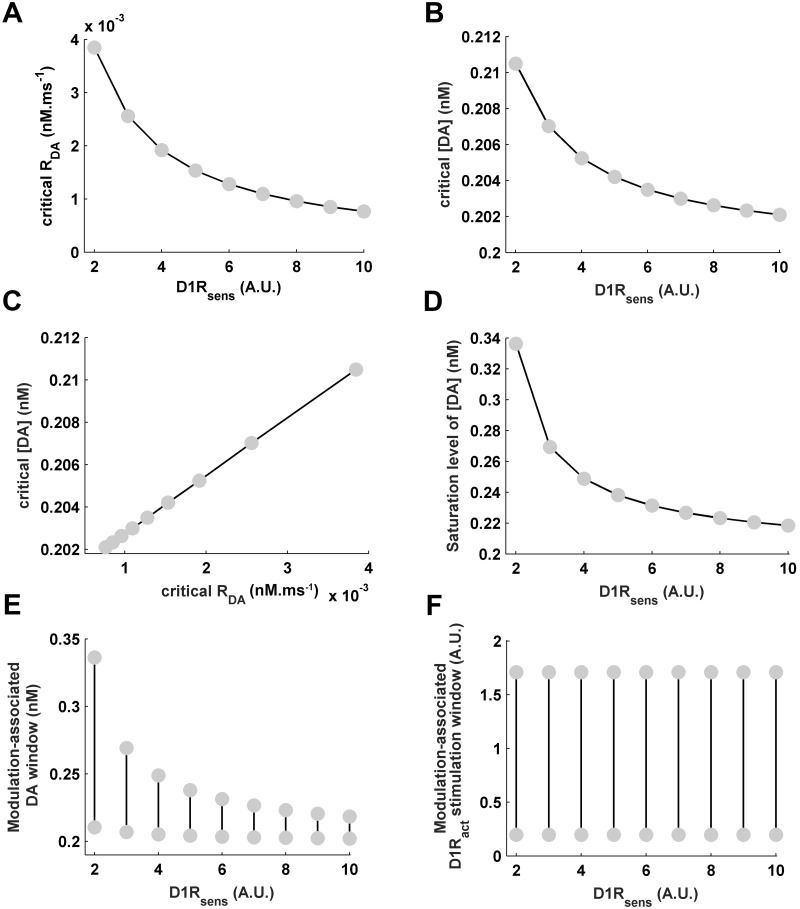
Effects of variation in D1R-sensitivity on the critical DA releasability, on the critical as well as saturations levels of cortical DA content, and on the modulation-associated windows of DA content and D1R stimulation.Increase in D1Rsens causes significant decrease in the critical RDA (A) and [DA] (B) marking an early beginning of the bifurcation regime. The variations in critical RDA and [DA] (C) exhibit a strong positive correlation. Moreover, the saturation level of [DA] (D) significantly decreases with increase in D1Rsens, causing the modulation-associated window of DA (E) to shift to lower values as well as shrinks in its span. However, the modulation-associated window of D1R stimulation (F) does not vary with change in D1Rsens.